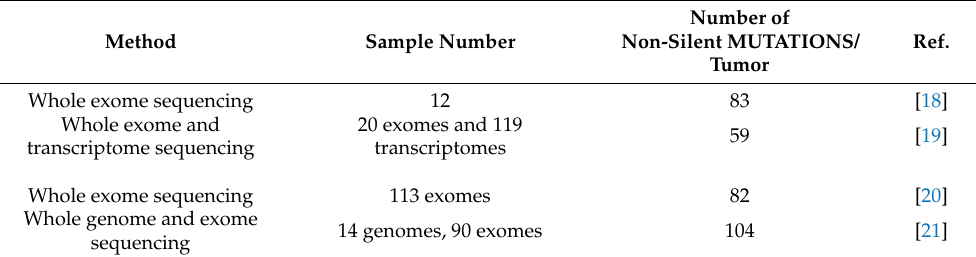
Table 1. NGS studies of oesophageal squamous cell carcinoma